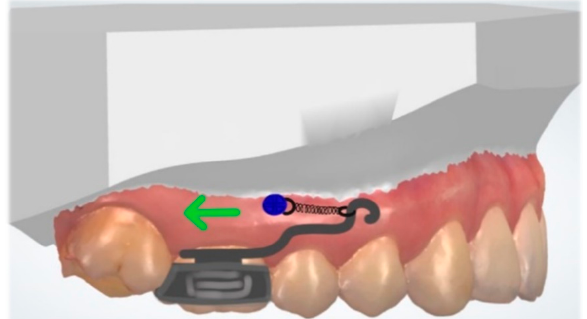
Figure 15. Unilateral molar distalization with cantilever connected to the TAD with a closed-coil spring (green: force).